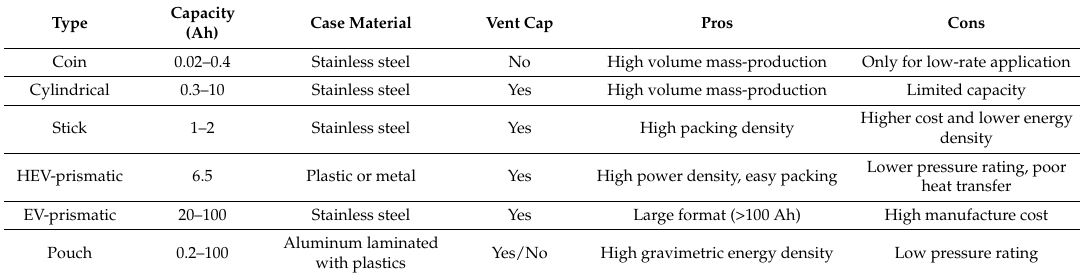
Table 2. Comparisons among various cell packaging types for Ni/MH